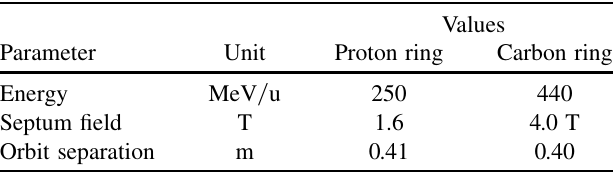
TABLE XXIV. Field strength of extraction septum.